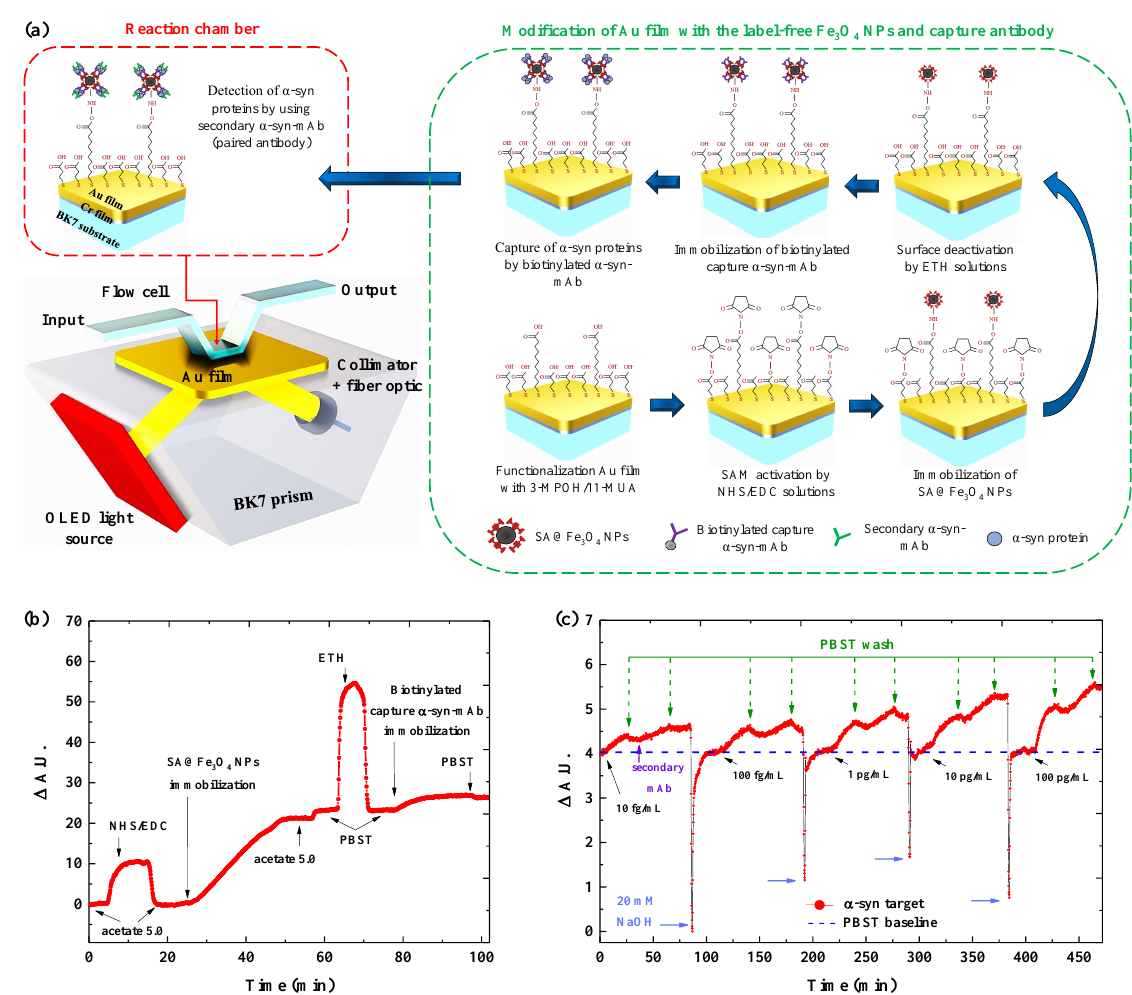
Figure 1. ( a ) Schematic configuration of the SPR sensor integrated with the OLED light source. Inset: the process of the surface modification and α -syn detection based on the label-free SA@Fe 3 O 4 NPs structure and antibody pairs on the Au film surface (the green-color box). ( b ) SPR sensorgram for sensor surface modification and ( c ) detection of α -syn protein at various concentration using pair of